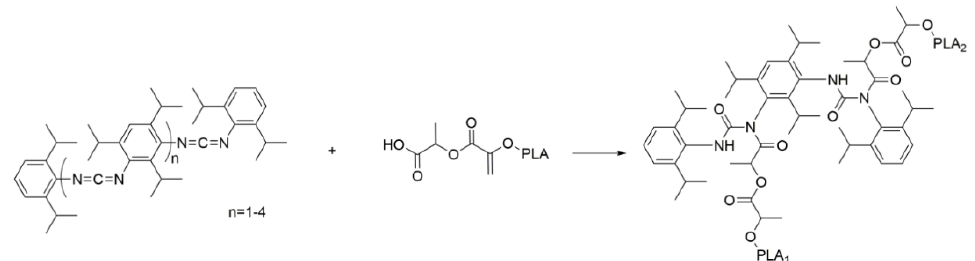
Figure 1. MFI results of PLA and PLA composites with and without FR and chain modifiers at 190 °C and 2.16 kg.